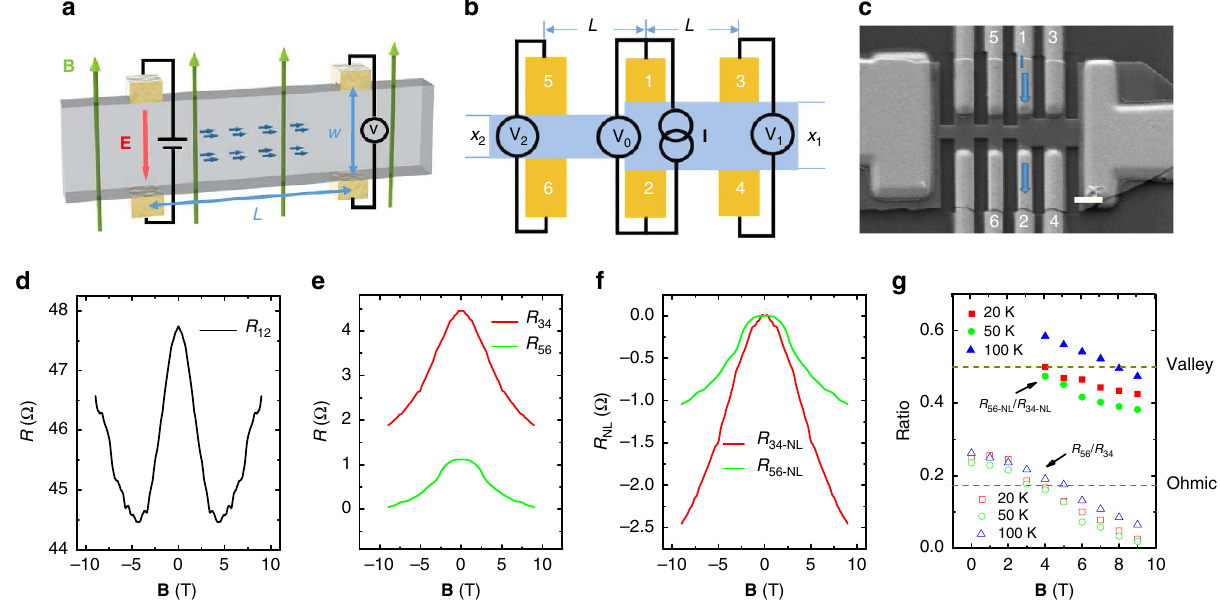
Figure 3 | Detection of valley transport in sample N2. ( a ) Schematic view of the valley diffusion process. Parallel (antiparallel) electric and magnetic fields generate the charge imbalance between two Weyl nodes due to the chiral anomaly. The charge imbalance of different valleys can diffuse across the sample and can be converted into a nonlocal voltage along the applied magnetic field direction. ( b ) Schematic view of the nonlocal resistance measurement with different diffusion channel width. Current is applied through terminal 1–2, while terminals 3–4 and 5–6 are used to measure the nonlocal resistance. The diffusion channel width ( x 1 and x 2 ) for 3–4 and 5–6 are 2 and 1 m m, respectively. The diffusion length L is 2 m m. ( c ) The scanning electron microscopy picture of the Cd 3 As 2 device. The white scale bar corresponds to 2 m m. The contact regime in terminals 3–4 is slightly larger than that of 5–6. ( d ) The two- terminal local resistance ( R 12 ) of the Cd 3 As 2 device at 20K. ( e ) The nonlocal resistance ( R 34 and R 56 ) at 20K. ( f ) The pure nonlocal resistance ( R 34-NL and R 56-NL ) after subtracting the Ohmic diffusion at 20K. ( g ) Resistance ratio of R 34 / R 56 and R 34-NL / R 56-NL as a function of B at different temperatures. The dash line valley and Ohmic correspond to 0.50 and 0.17, respectively. R 34-NL / R 56-NL at low field ( o 4T) is not plotted since the value of R 34-NL or R 56-NL is close to zero and the corresponding ratio is easily affected by fluctuations or small